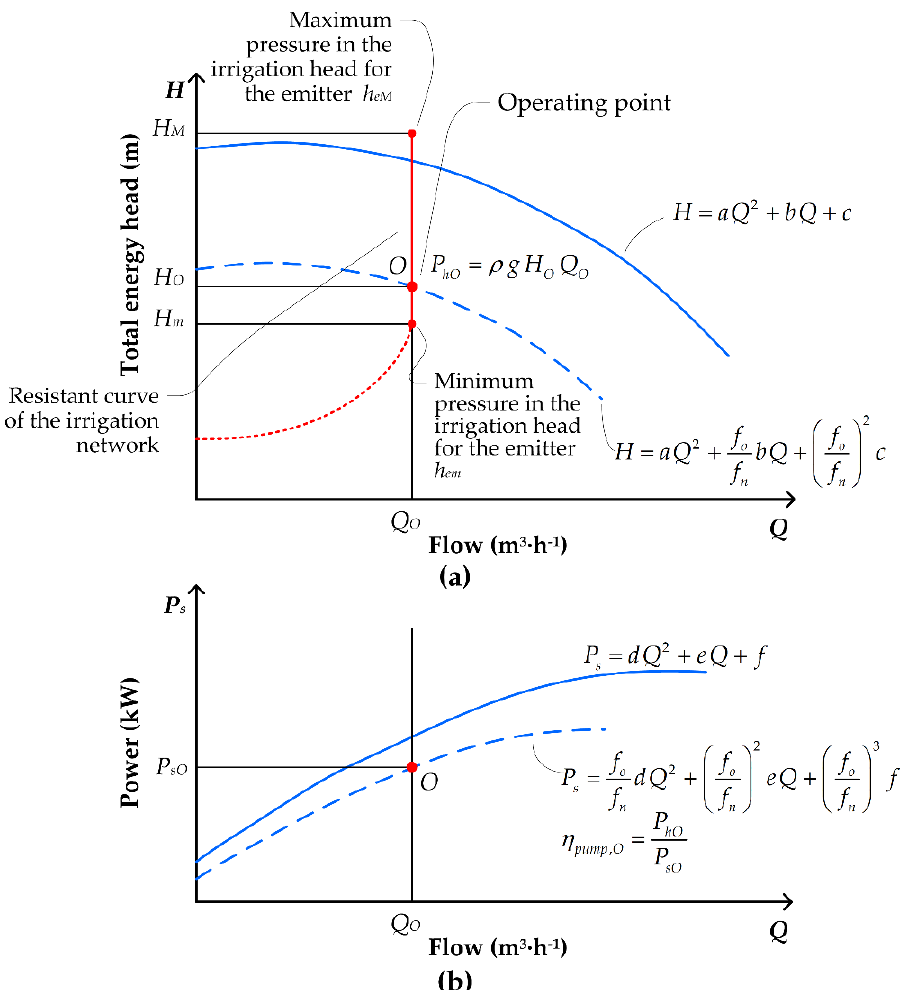
Figure A1. Application of the laws of similarity to the characteristic curves of the centrifugal pump. Operating point O . ( a ) H − Q diagram. In blue: continuous line H − Q at nominal conditions and dashed line H − Q at operating point. In red: H − Q load curve. ( b ) P s − Q diagram. In blue: continuous line P s − Q at nominal conditions and dashed line P s − Q at operating point.